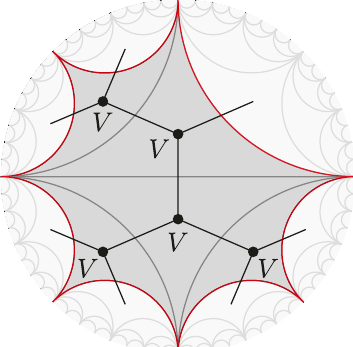
Figure 13 . We can form holographic states by placing a (cid:12)xed perfect tensor V in every triangle of a cuto(cid:11) coming from a given tessellation, and contracting tensor indices whenever two triangles share a common edge. Since we have taken V to be rotation invariant the orientation of V does not matter.